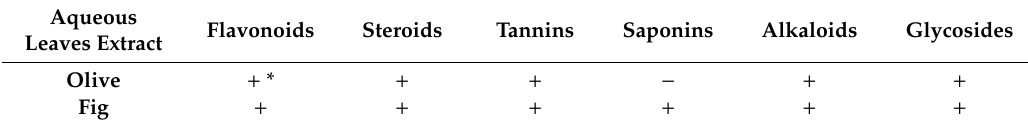
Table 3. Preliminary phytochemical screening of fig and olive leaf aqueous extract.